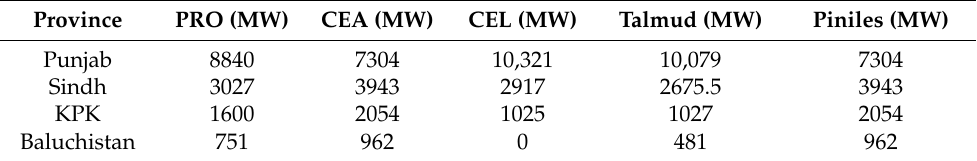
Table 3. Power allocation under five “bankruptcy rules”.